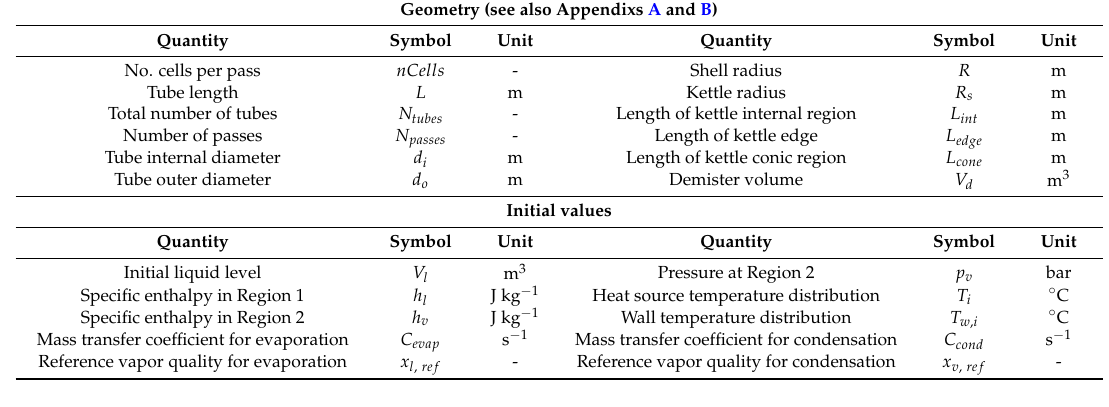
Table 3. Parameters and initial value for kettle boiler model.